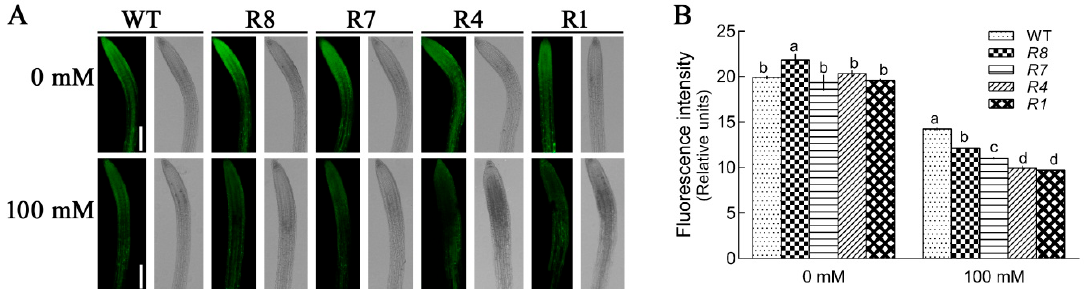
Figure 9. Effect of salt stress on cell viability in wild-type (GL1) and CPK12 -RNAi lines. (A) Seven-day-old seedlings were transferred to MS medium supplemented with or without 100 mM NaCl for 12 h. Cell viability was assayed with fluorescein diacetate (FDA, green) stain. Representative images of apical region of roots are shown. Scale bars, 100 μ m. ( B ) The fluorescence intensity (±SD) represents the mean of 10 independent seedlings. The mean values of FDA fluorescence are labeled with letters in the same group to denote significant differences ( p < 0.05).